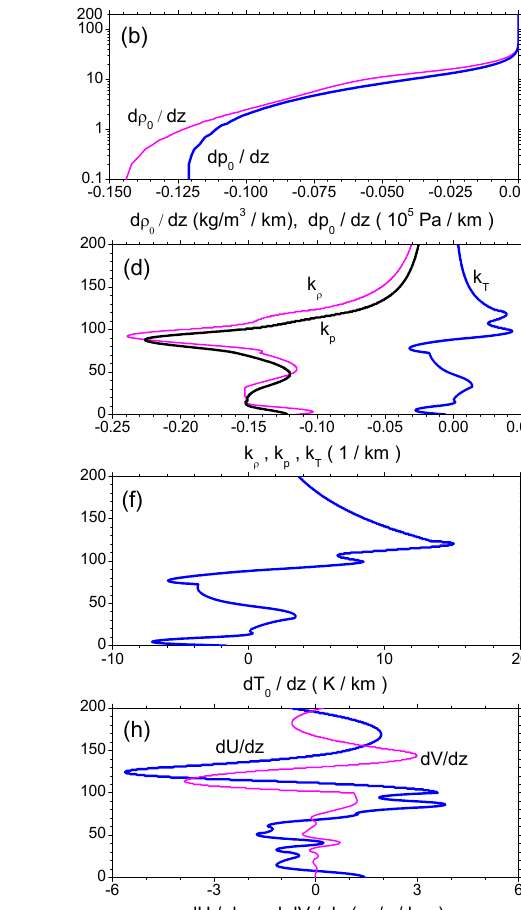
Figure 1. Altitude profiles of mean-field properties. ( a ) Mass density ρ 0 (pink) and pressure p 0 (blue); ( b ) density gradient d ρ 0 /d z (pink) and pressure gradient d p 0 /d z (blue); ( c ) density scale height H ρ (blue) and pressure scale height H p (pink); ( d ) density scale number k ρ (pink), pressure scale number k p (black) and temperature scale number k T (blue); ( e ) temperature T 0 (blue) and sound speed C (pink); ( f ) temperature gradient d T 0 /d z ; ( g ) zonal (eastward) wind U (blue) and meridional (northward) wind V (pink); ( h ) zonal wind gradient d U /d z (blue) and meridional wind gradient d V /d z (pink); in (e), a dashed line in red is given as a reference to show an ideal atmosphere, which is isothermal at all